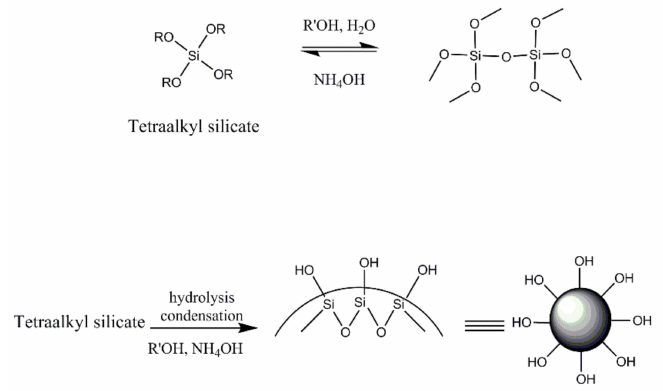
Figure 1. Schematic illustration of the Stöber